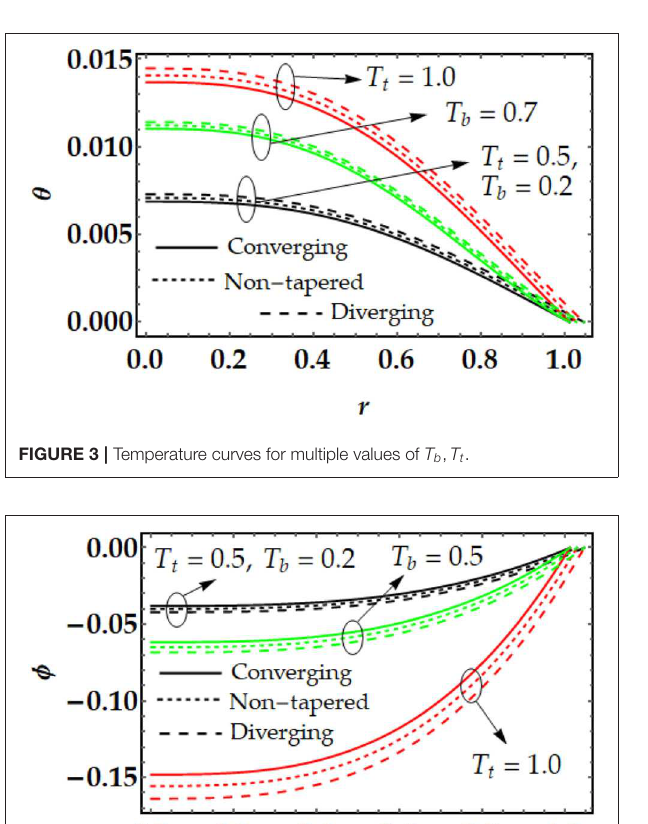
FIGURE 2 | Velocity curves for multiple values of (A) β , (B) T t , (C) T b .